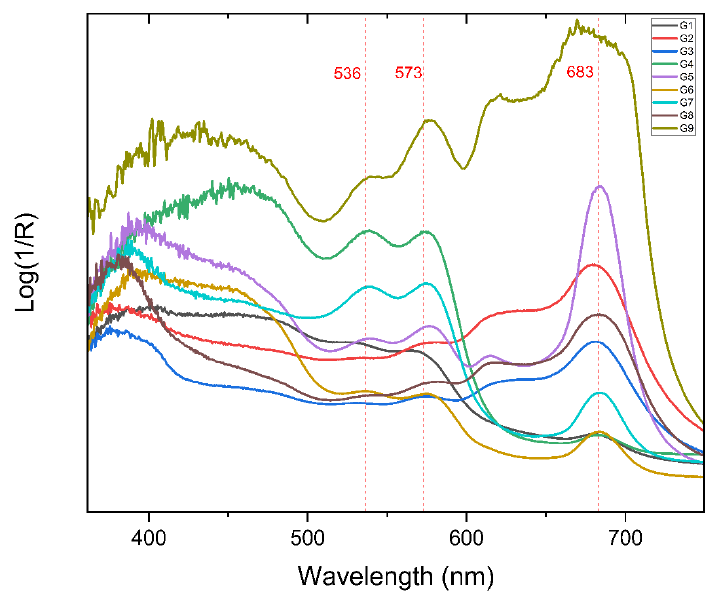
Figure 6. Absorption bands obtained by FORS spectrophotometer from Paolo Gioli’s original artwork.